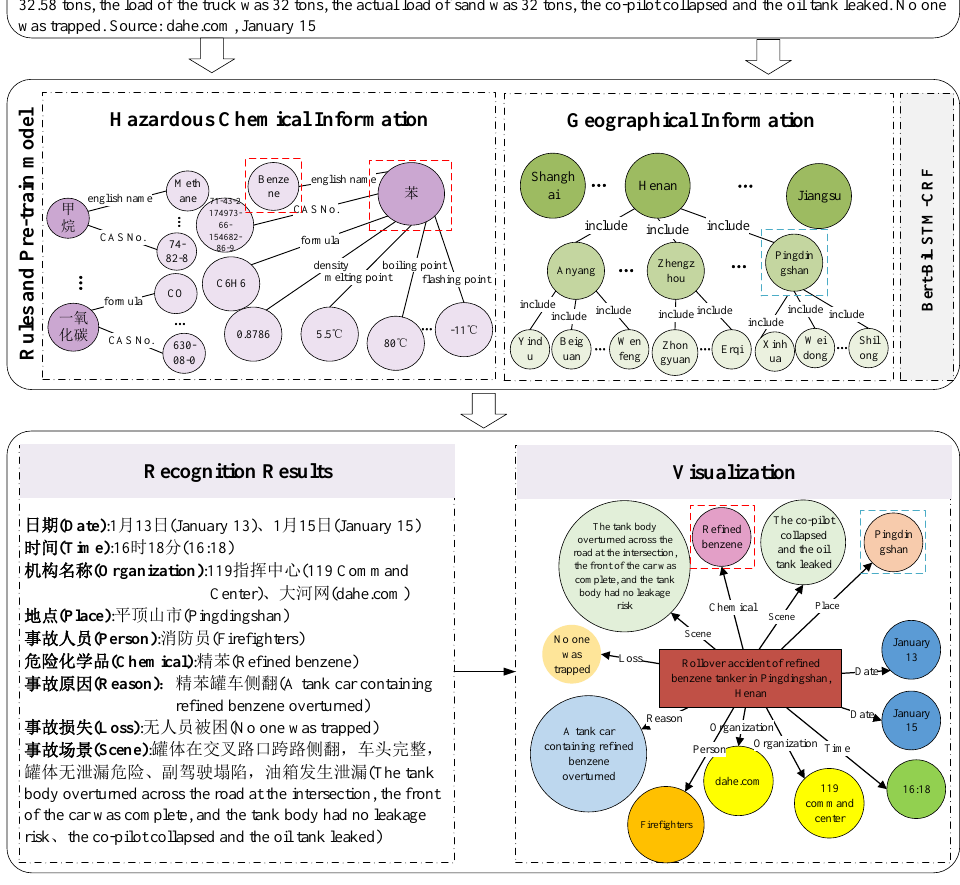
Figure 1. An example of accident information entity